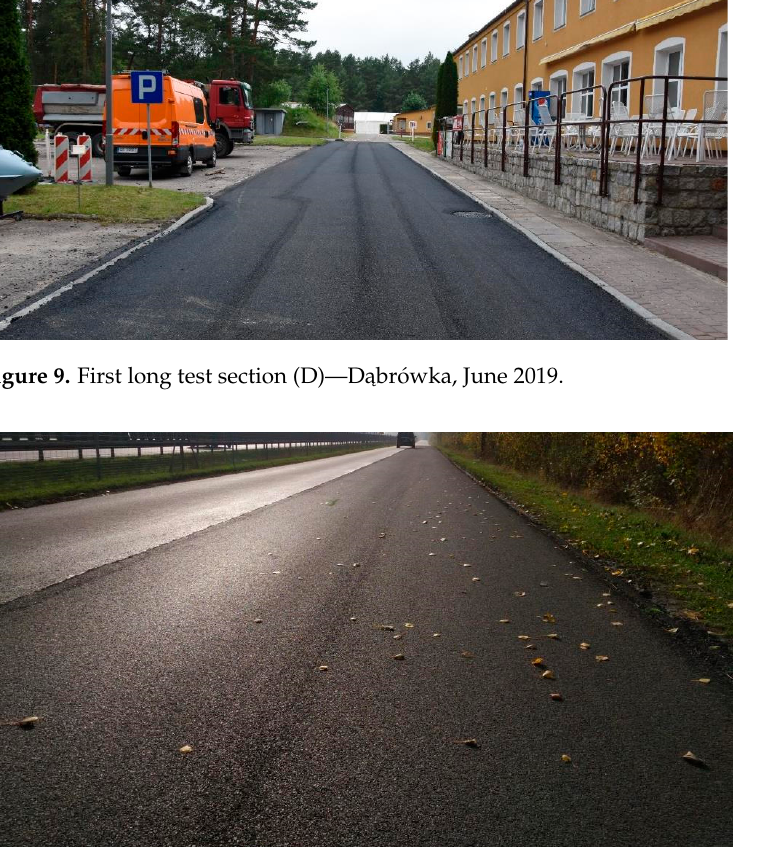
Figure 10. Second long test section (G)–Galaktyczna St., Gda ń sk, September 2019.